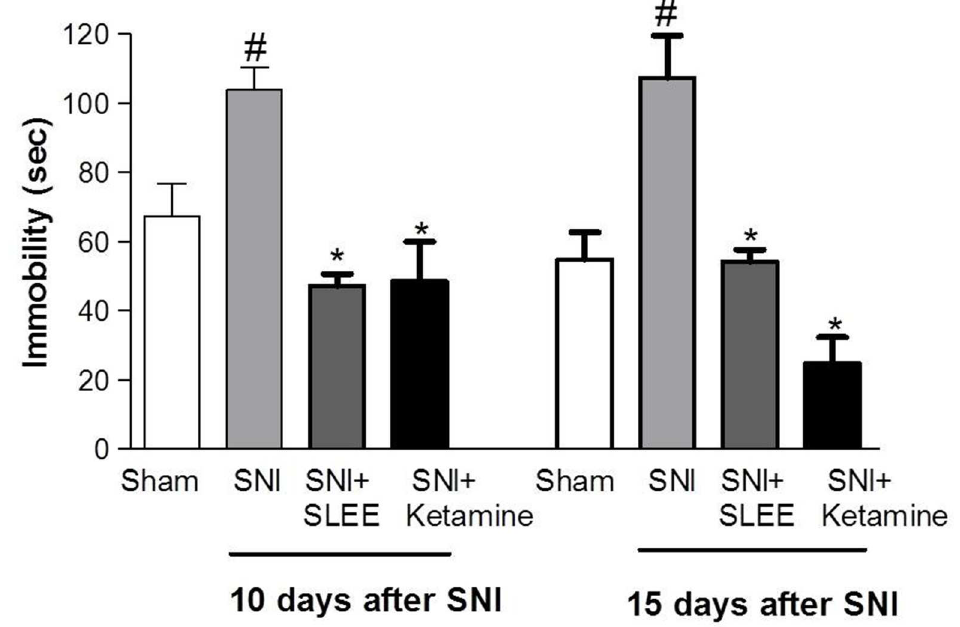
Fig 2. Effect of oral administration of SLEE on SNI-induced increasesin immobility in rats during the forced swim test. The groups receivedSham, SNI, SNI+SLEE (100 mg/kg, p.o.) or SNI+ketamine (10 mg/kg, i.p.) treatments. Bars represent the time of immobilityon the 10 th and 15 th days after SNI. Bars express the mean ± SEM(n = 8) comparing the SNI vs. treated ( * P < 0.05) or sham ( # P <